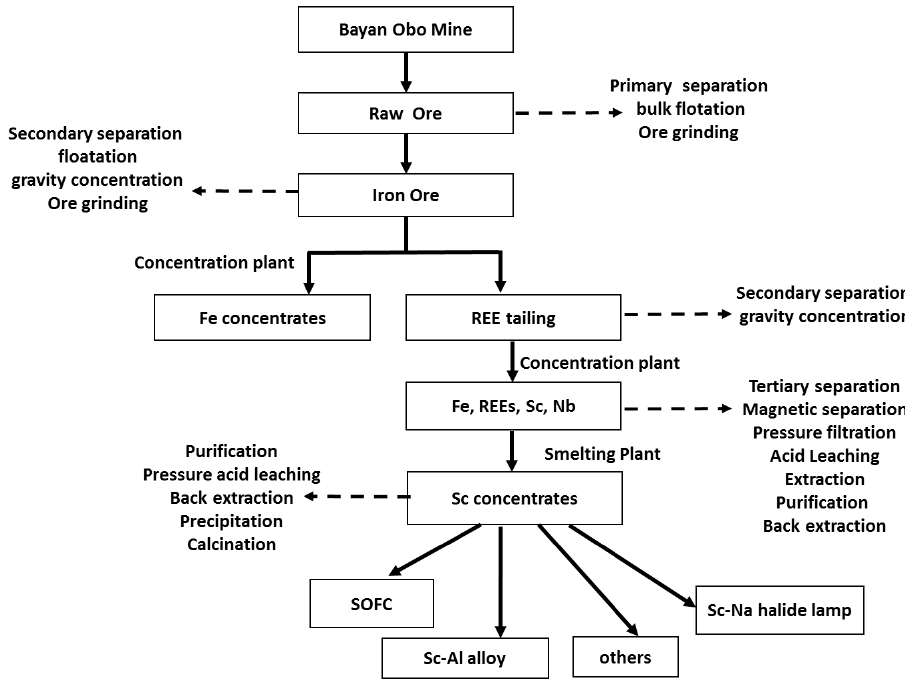
Figure 1. Sc 2 O 3 from Byan Obo Mine’s REEs